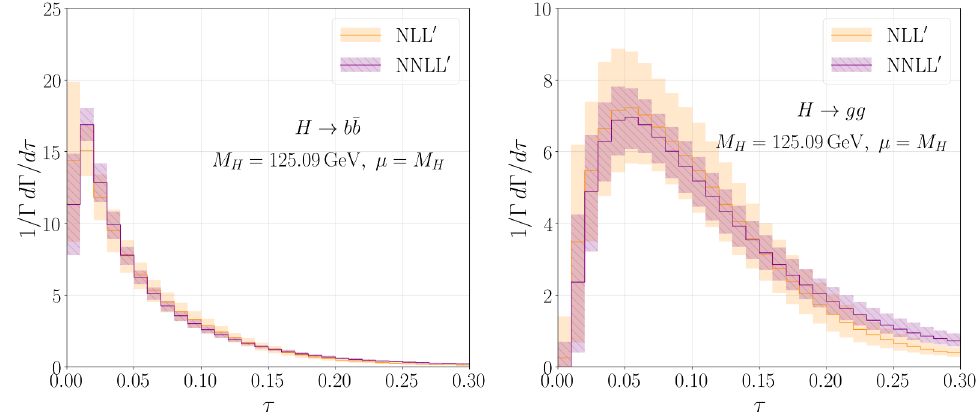
Figure 1. The normalised, resummed spectrum in (cid:28) (cid:17) T 2 = (2 M H ) , corresponding to eq. (2.5), at NLL 0 and NNLL 0 . The left panel shows the process H ! b (cid:22) b , the right shows H ! gg